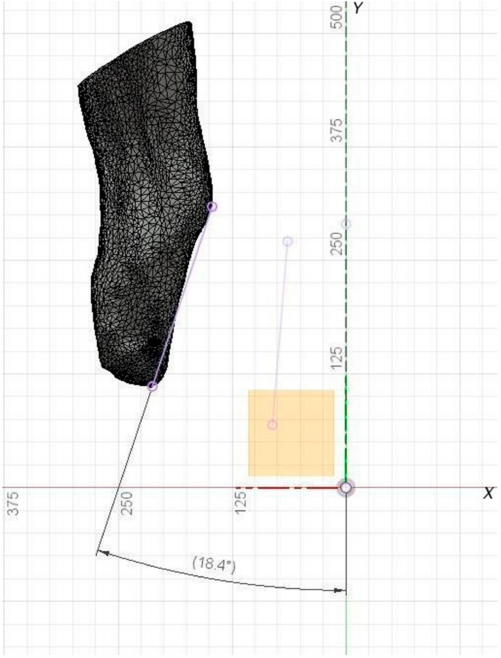
Figure 6. Inclination angle calculation.